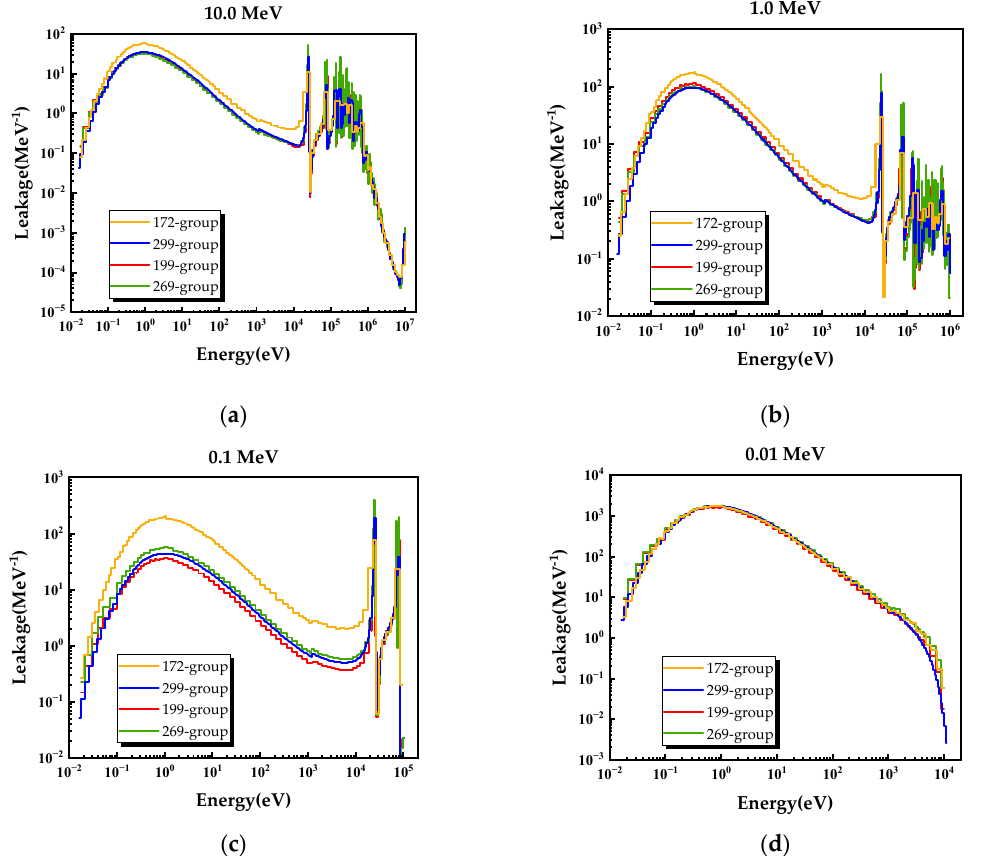
Figure 12. Four different single-energy source neutron leakage spectra for iron spheres: ( a ) 10.0 MeV, ( b ) 1.0 MeV, ( c ) 0.1 MeV, and ( d ) 0.01 MeV.